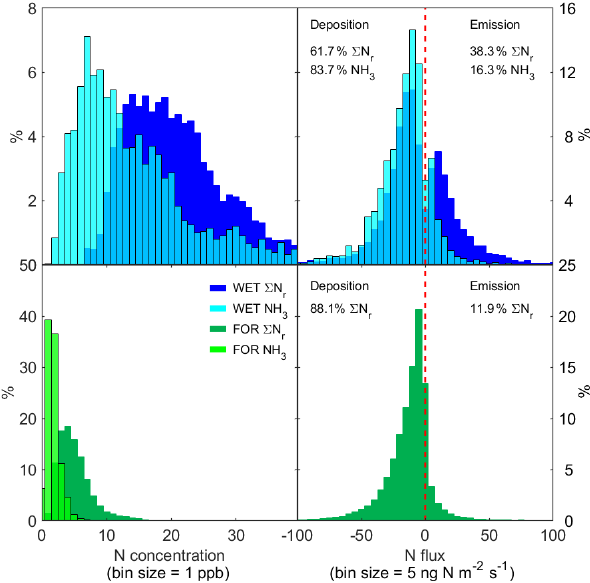
Figure 5. Frequency distribution of half-hourly campaign concen- trations and fluxes; n = 9005 at WET (cid:54) N r campaign, n = 2916 at WET NH 3 campaign, n = 42635 at FOR (cid:54) N r campaign, and n = 23046 at FOR NH 3 campaign; positive flux values indicate emission, and negative flux values indicate deposition of